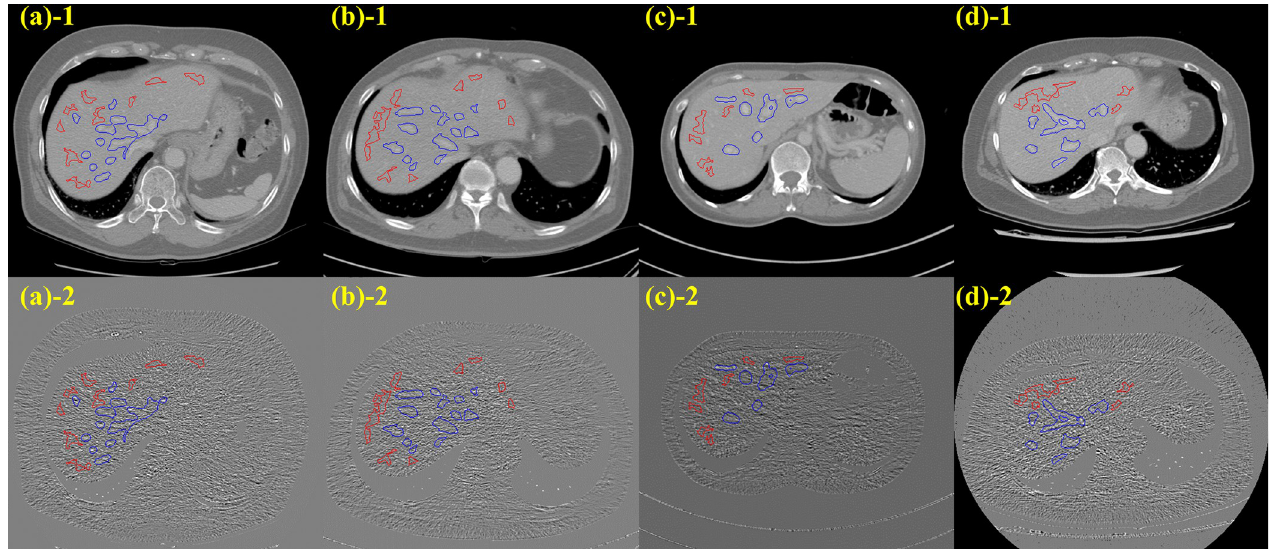
Fig 11. Upper row showed the homogeneous (red) and structure edge (blue) region on enhanced hepatic area displayed in the image domain, whereas the lower row shows same ROIs displayed on the subtraction image domain. Each image was acquired with a) Scanner 1, (b) Scanner 2, (c) Scanner 3, and (d) Scanner 4,